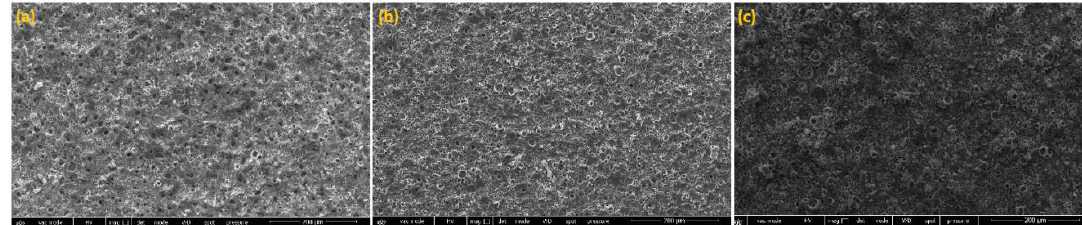
Figure 1. SEM images of plasma electrolytic oxidation (PEO) coatings of the three coatings TiCu300 ( a ), TiCu450 ( b ), TiCu600 ( c ).